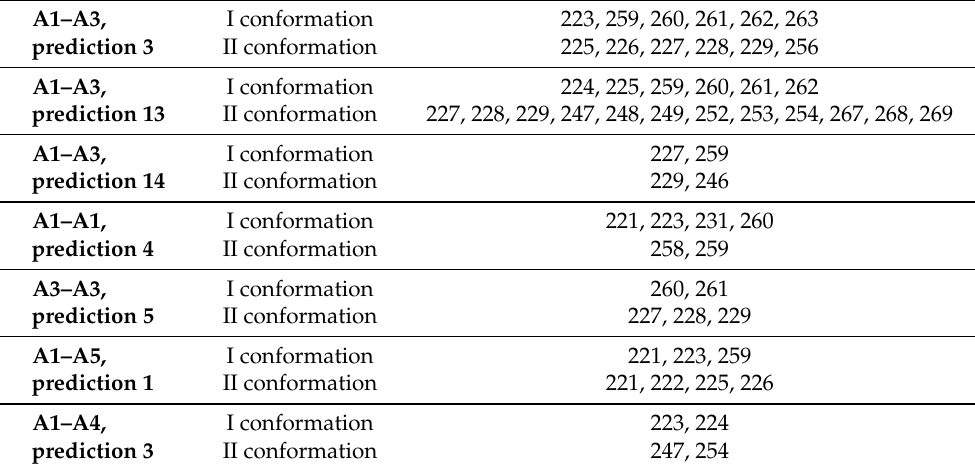
Table 1. List of the residues found in contact in the post-MD simulation complexes. Interacting residues are defined as the one whose C α atoms have a distance lower than 8 Å with the partner C α